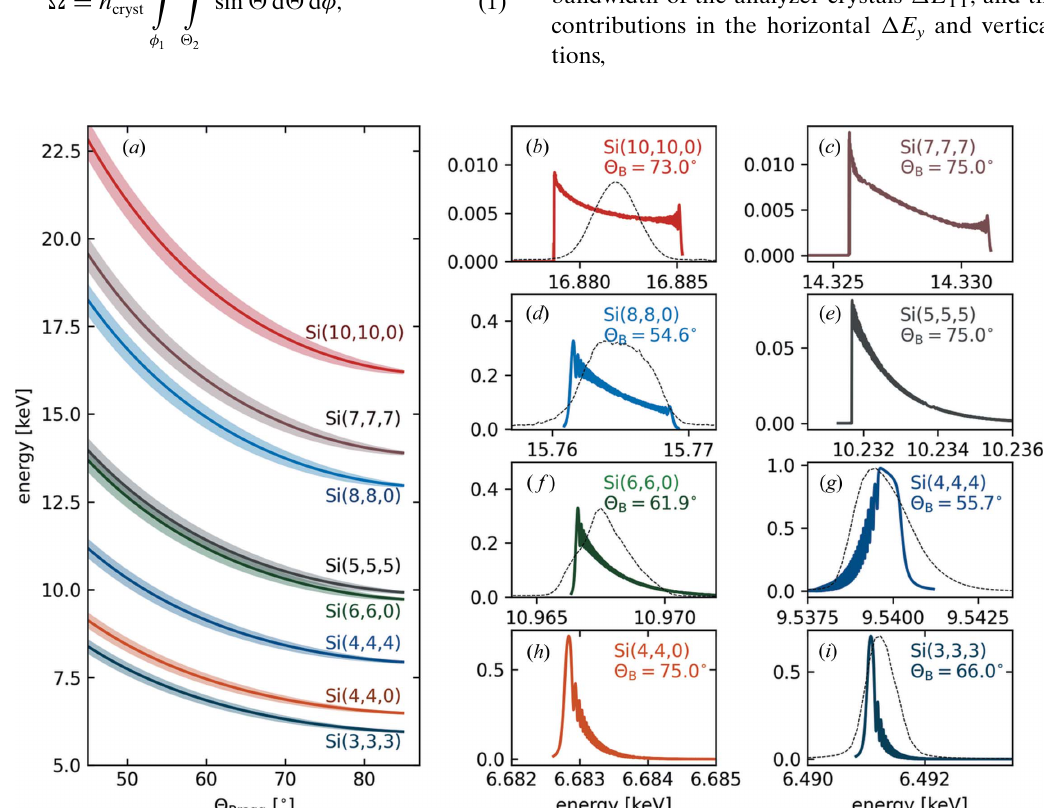
Figure 2 ( a ) DuMond diagram for bent R = 250 mm Si crystals for different ( n , n ,0) and ( n , n , n ) lattice planes. Shaded areas represent the energy window covered by the analyzer crystals. ( b )–( i ) Calculated (colored) and experimental (thin dashed) reflectivity curves between ca . 6 and 17 keV. All theoretical reflectivity curves were obtained by solving the 1D Tagaki–Taupin equations (Takagi, 1962, 1969; Taupin, 1964) using the pyTTE package by Honkanen & Huotari